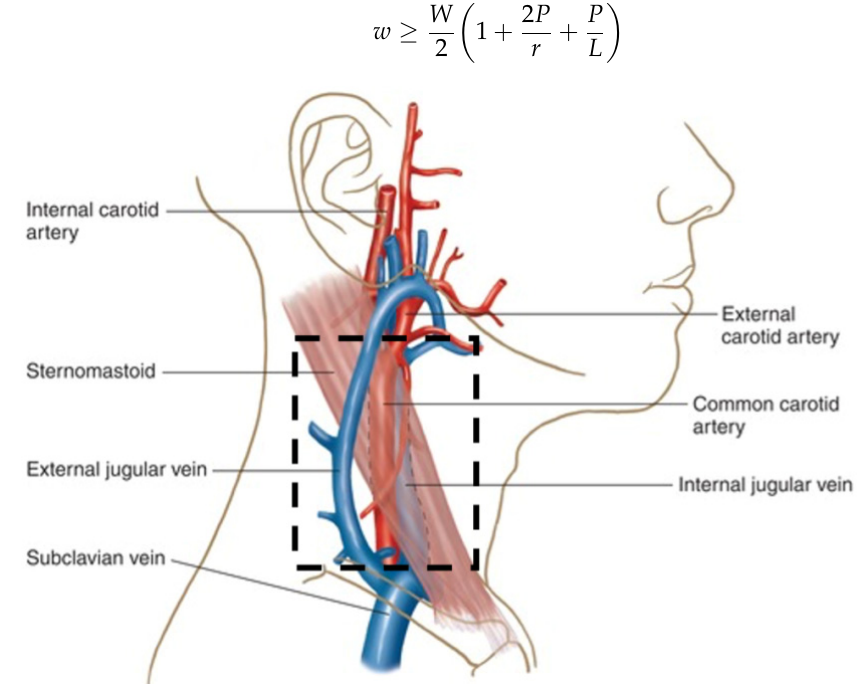
Figure 4. Carotid artery (CA) and Jugular Vein (JV) branches and region of interest (ROI) identified with a black rectangle.